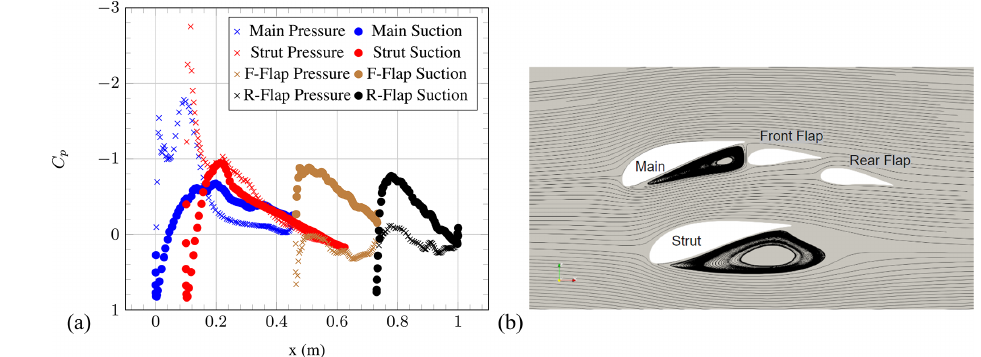
Figure 7. (a) Pressure coefficient of the individual element airfoils and (b) streamlines at AoA = 0 ◦ (OpenFOAM simulations).